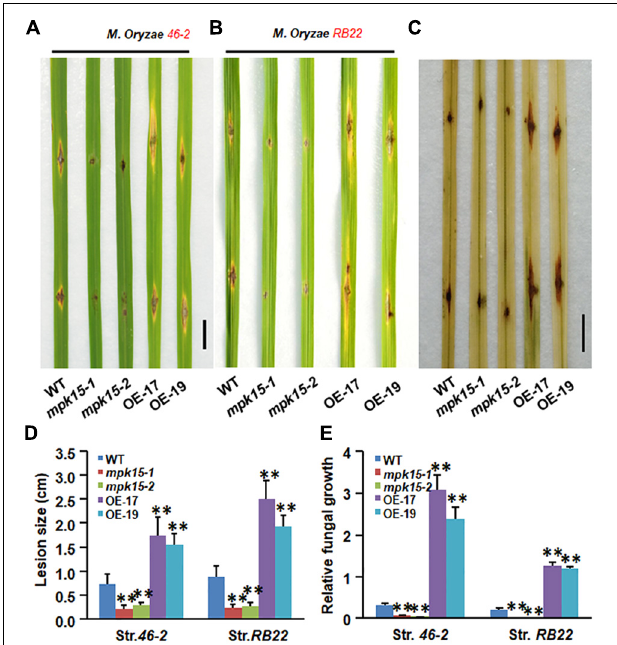
FIGURE 3 | OsMPK15 negatively regulates M. oryzae disease resistance in detached leaves. (A,B) Phenotype of the at 30-days-old WT, mpk15 mutant, and OsMPK15-OE plants inoculated by the punch method with spore suspension (1 × 10 5 per ml) of M. oryzae strain 46-2 or race RB22 at 6 dpi. Bars indicate 1 cm. (C) DAB staining in M. oryzae strain RB22 inoculated leaves of WT, mpk15 mutant, and OsMPK15-OE plants at 6 dpi. Bars indicate 1 cm. (D) Disease lesion size statistics of M. oryzae strain 46-2 inoculated WT, mpk15 mutant, and OsMPK15-OE plants. At least 30 plants in each experiment were evaluated for lesion size with three replicates. (E) Quantification of M. oryzae growth in strain 46-2 and RB22 -inoculated leaves of the WT, mpk15 mutant, and OsMPK15-OE plants at 6 dpi. Amounts of M. oryzae 28S rDNA and rice OsEF1 genomic DNA were estimated by qRT-PCR and relative fungal growth were shown as ratios of Mo28S / OsEF1 . Three independent experiments were performed with similar results in (A – E) Data presented in (D,E) are the mean ± SD from three independent experiments. ∗ P ≤ 0.05; ∗∗ P ≤ 0.01 (Student’s t